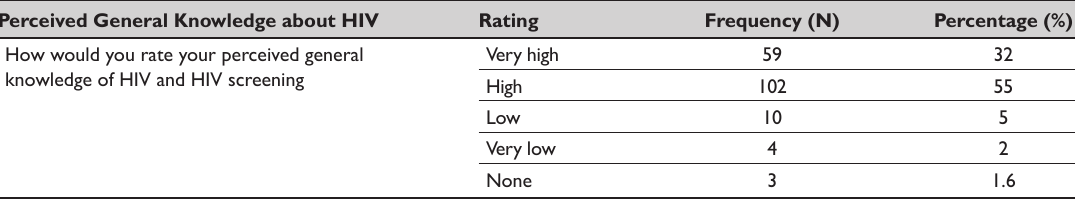
Table 2: Perceived general knowledge about HIV Perceived General Knowledge about HIV